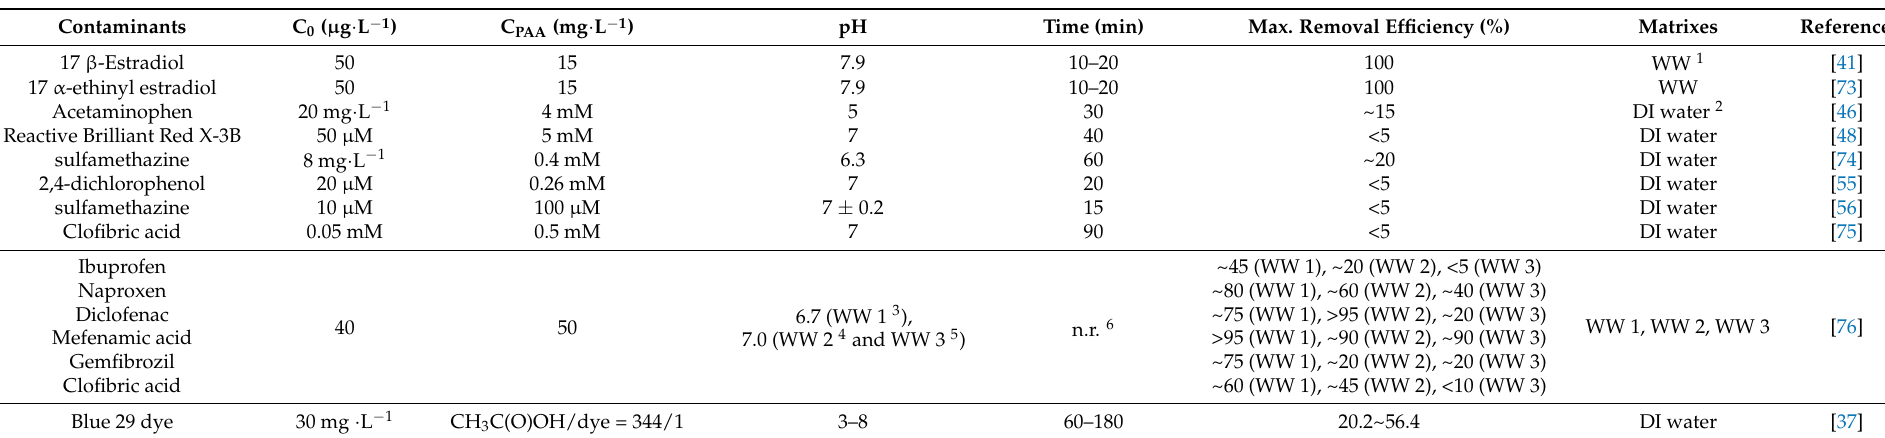
Table 2. An overview of research on the direct oxidation of aqueous pollutants by